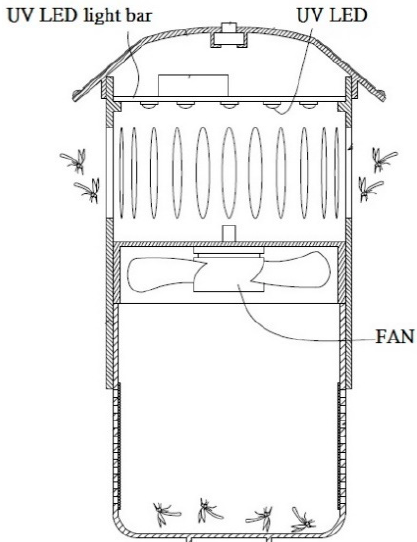
Figure 1. Conventional light-emitting diode (LED) mosquito trapping system.